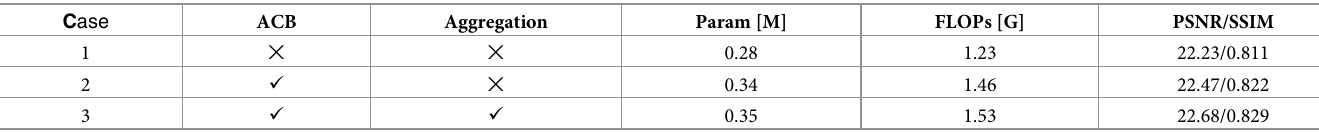
Table 4. Study on Information Aggregation Block (IAB). ACB, Aggregation are asymmetric convolutional block, aggregation structure respectively. C ase ACB